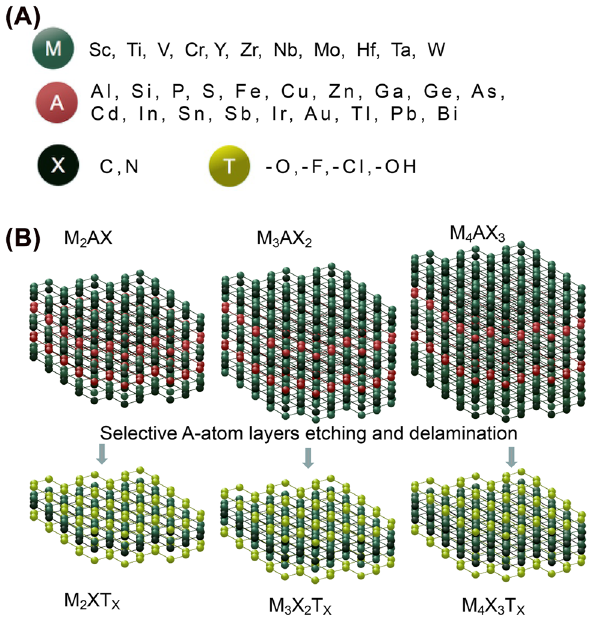
Figure 1: The elements and structures of MXenes. (A) Chemical formula of MXenes. Wherein M represents an early transition metal element (Sc, Ti, V, Cr, Y, Zr, Nb, Mo, Hf, Ta, W, etc.), A means a group element including Al, Si, P, S, Fe, Cu, Zn, Ga, Ge, As, Cd, In, Sn, Sb, Ir, Au, Tl, Pb, Bi, etc. X represents C or N. T represents a surface end group (–OH, –O, –F, etc.). (B) Etching processes from MAX to MXenes